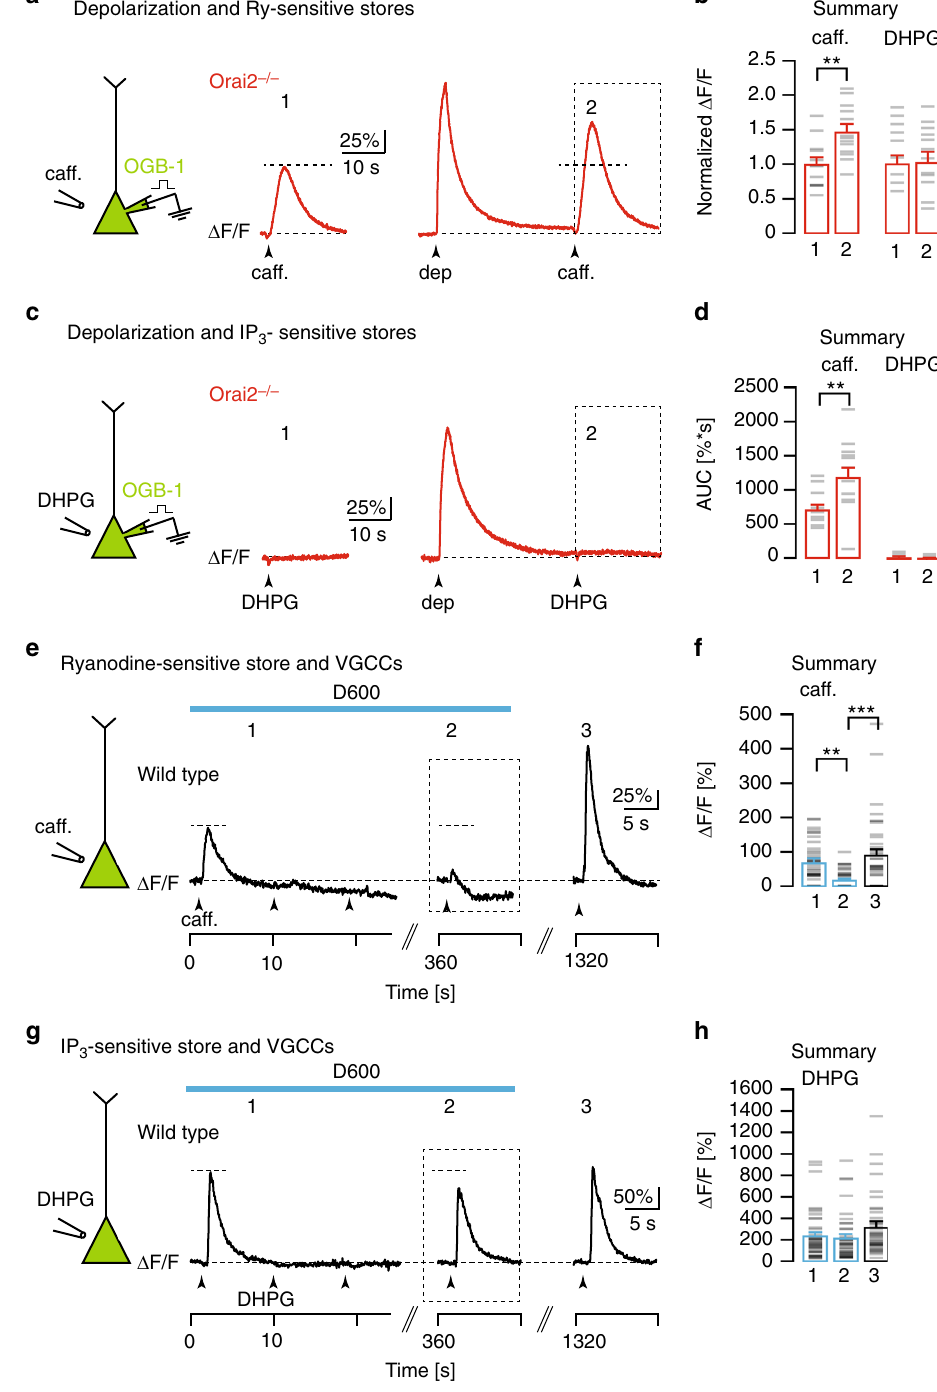
heterozygously preserved the loxP - fl anked Orai1 gene and thus generated Ora1 loxP / − mice. Orai1 CA1ko/ − mice were created by using appropriate breeding steps and careful genotyping. The procedures for Orai2 gene targeting and the generation of Orai2-de fi cient mice (Orai2 − / − ) have been previously reported 20 . The genotypes of Orai1 loxP/ − , Orai1 CA1ko/ − , T29-1 mice, and Orai2 − / − mice were con fi rmed by PCR of tail tissue. The loxP sites on the Orai1 locus